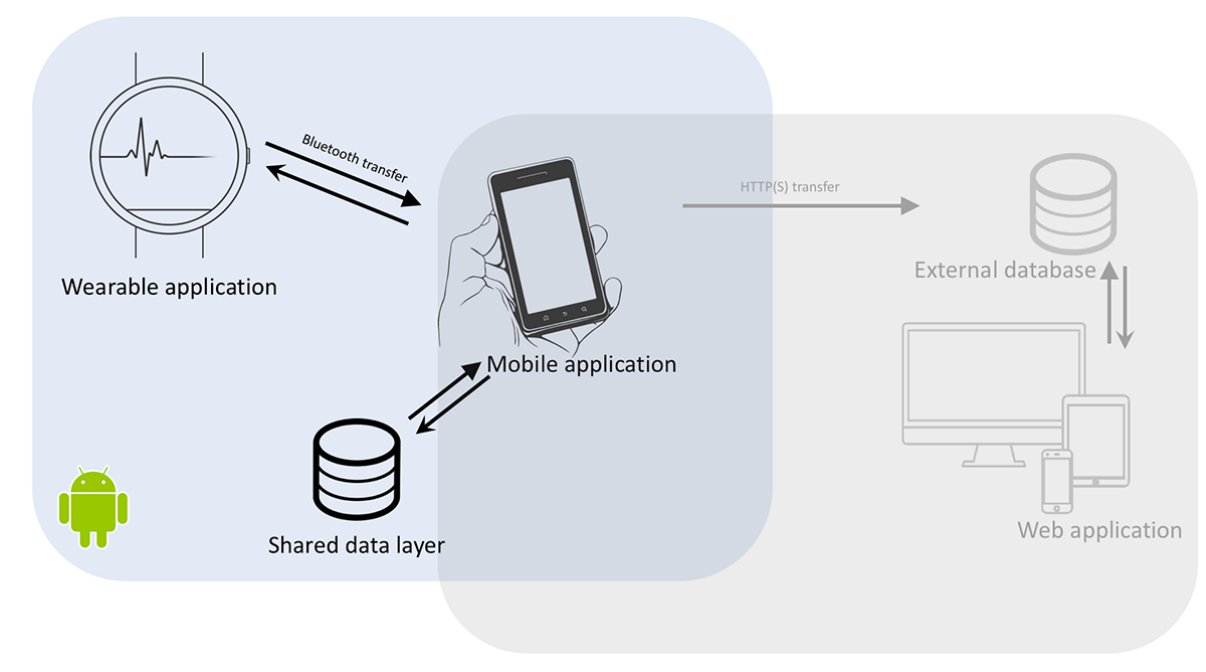
Figure 3. Overview of the setup of the Sense-IT app.